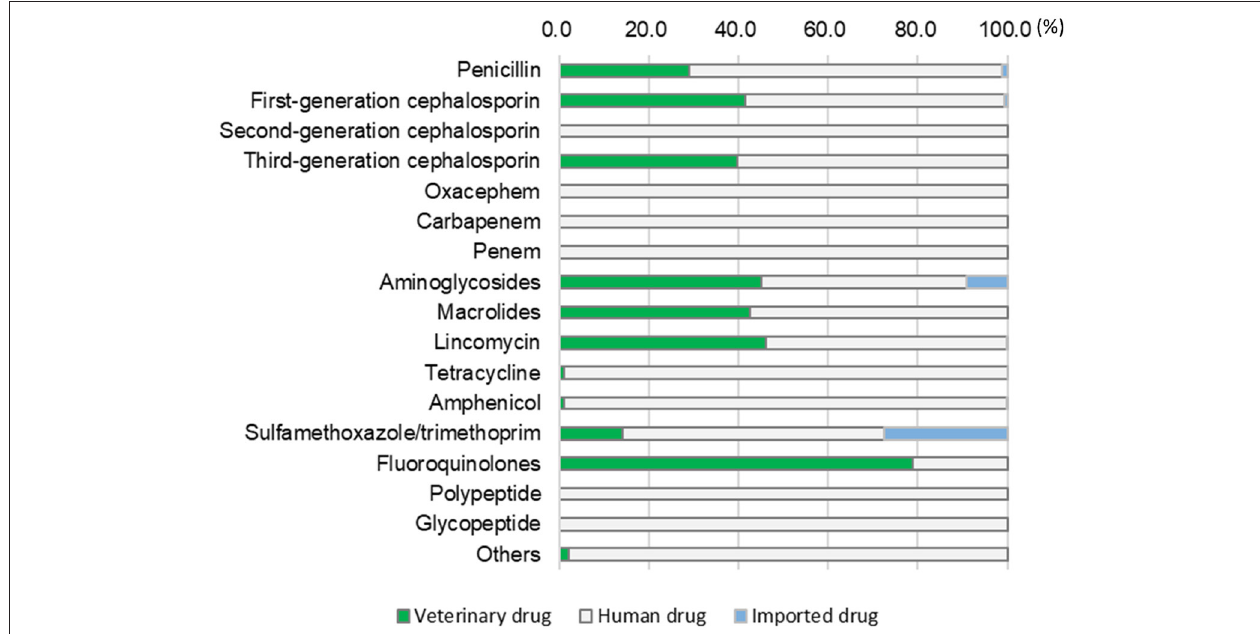
FIGURE 2 | Proportions of antimicrobial drugs used in the studied clinics, categorized by drug type (veterinary, human, or imported).